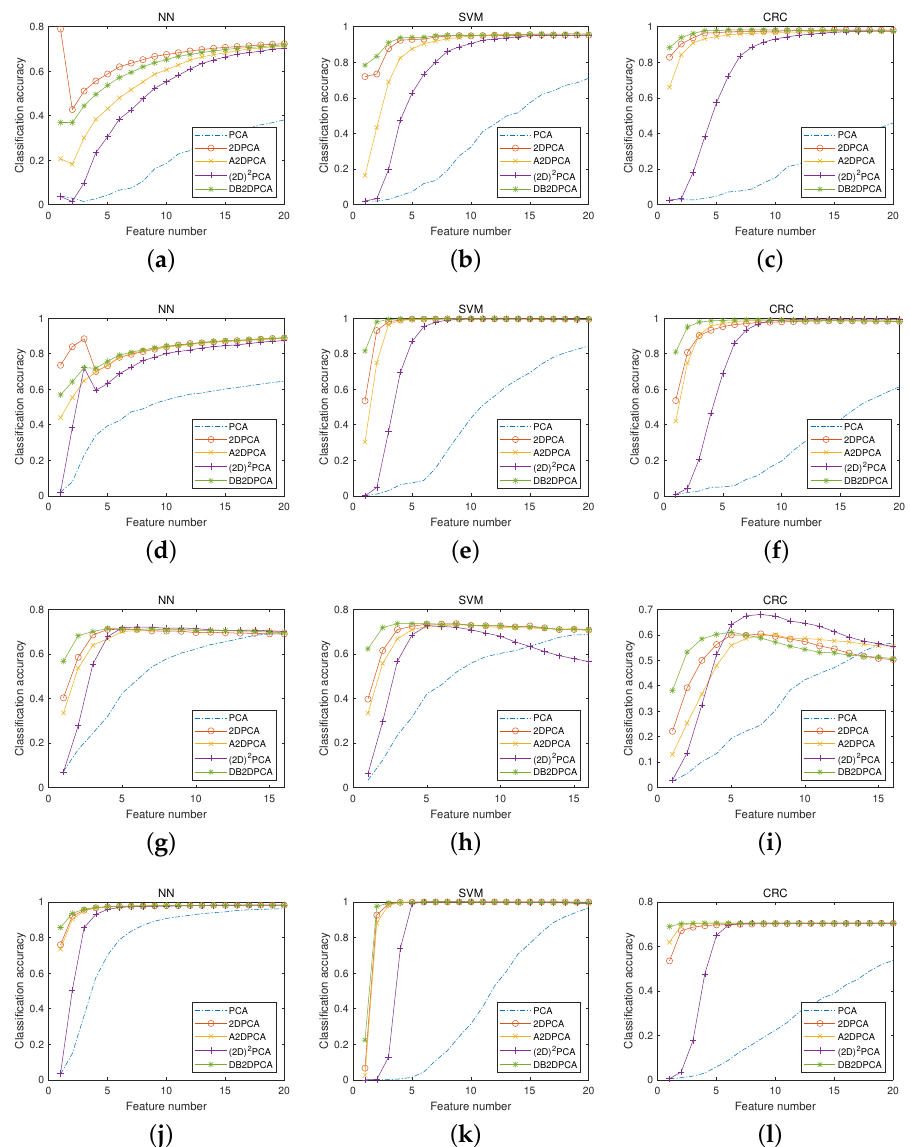
Figure 8. The average classification accuracies on four databases by three different classifiers. The sub- figures in the four rows are results of the Extended Yale B face database, AR face database, Binary Alphadigits database and PolyU 3D palmprint database, respectively. The subfigures ( a – l ) in three columns are results of NN, linear SVM and CRC, respectively. In each subfigure, there are five accuracy curves corresponding to the five feature extraction algorithms, i.e., PCA, 2DPCA, A2DPCA, ( 2D ) 2 PCA and